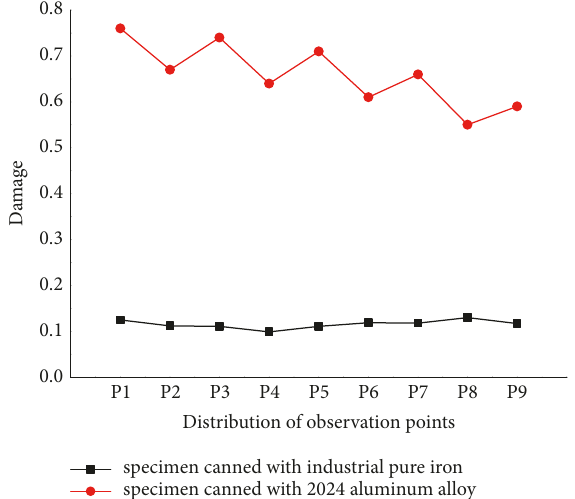
Figure 18: Comparison of damage value curves obtained by using the SPH